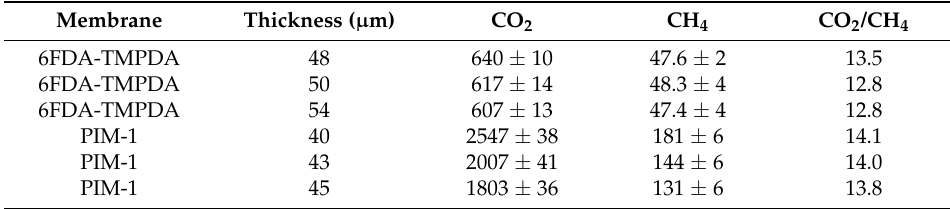
Table 5. Single gas CO 2 and CH 4 permeabilities (barrer) through 6FDA-TMPDA and PIM-1 composite membranes with Teflon AF1600, denoted by overall membrane thickness, at 35 ◦ C.